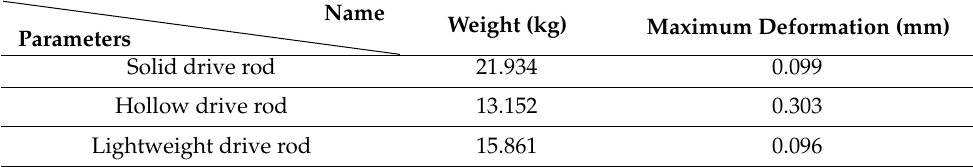
Table 3. Comparison of analysis results of three drive